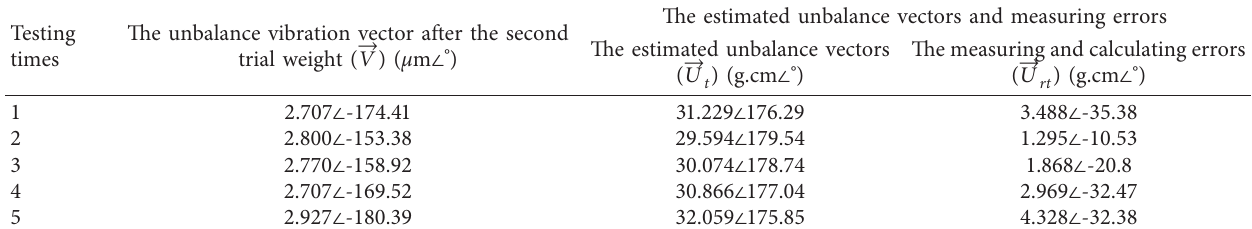
Table 2: The estimated unbalance vectors of 5-time testing.